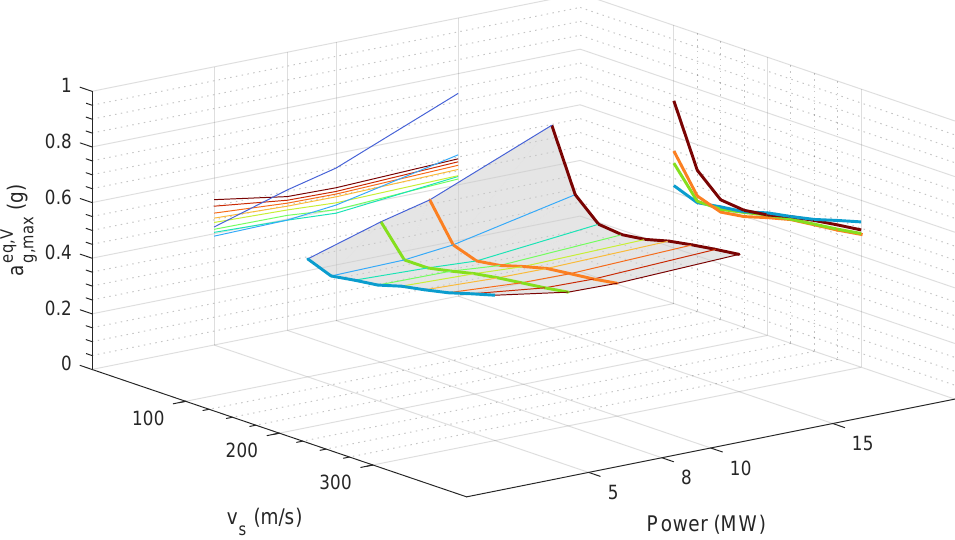
Figure 8. Equivalent ground maximum acceleration for the shear forces at the mudline level. Mean value of the results corresponding to different accelerograms. Influence of soil stiffness and tur- bine